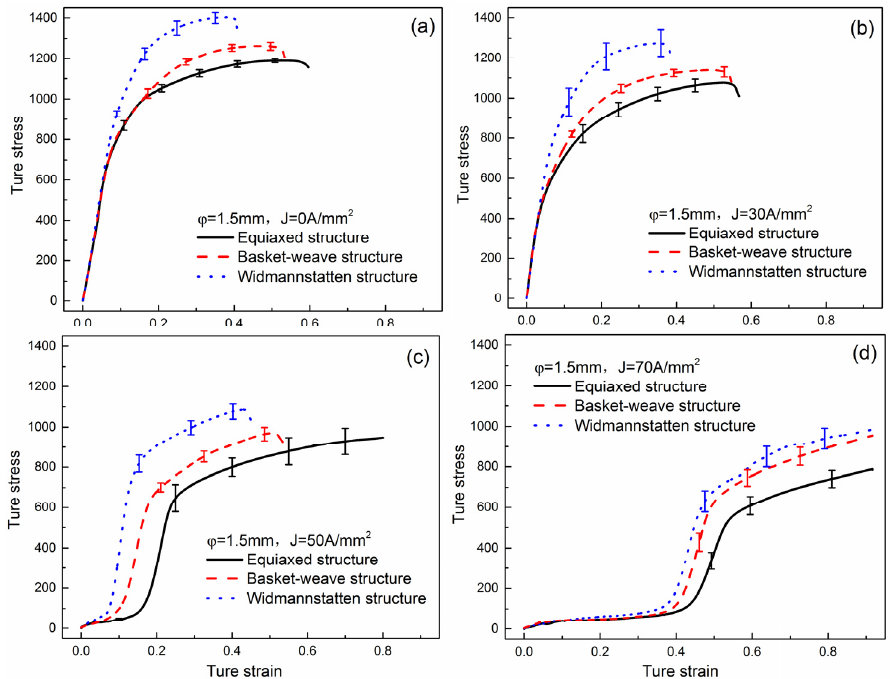
Figure 11. True stress-true strain curves of different initial microstructure specimens under varying current densities: ( a ) 0 A/mm 2 , ( b ) 30 A/mm 2 , ( c ) 50 A/mm 2 , ( d ) 70 A/mm 2 .